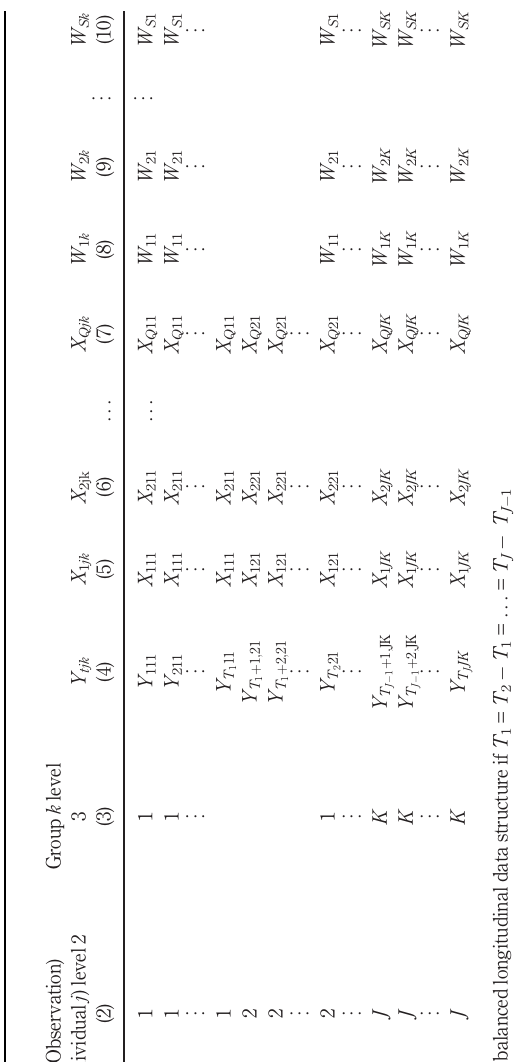
Table II. General model of a dataset with a three- level nested data structure with repeated